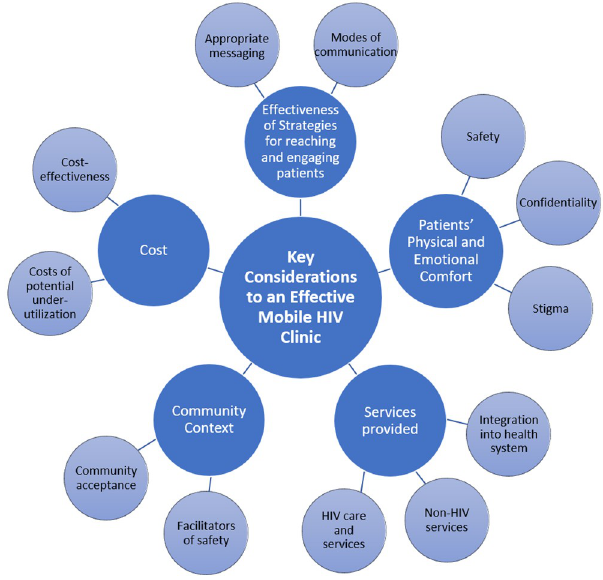
Fig 1. Key considerations to implementation of a mobile HIV care model to reach people living with HIV who are out of care.